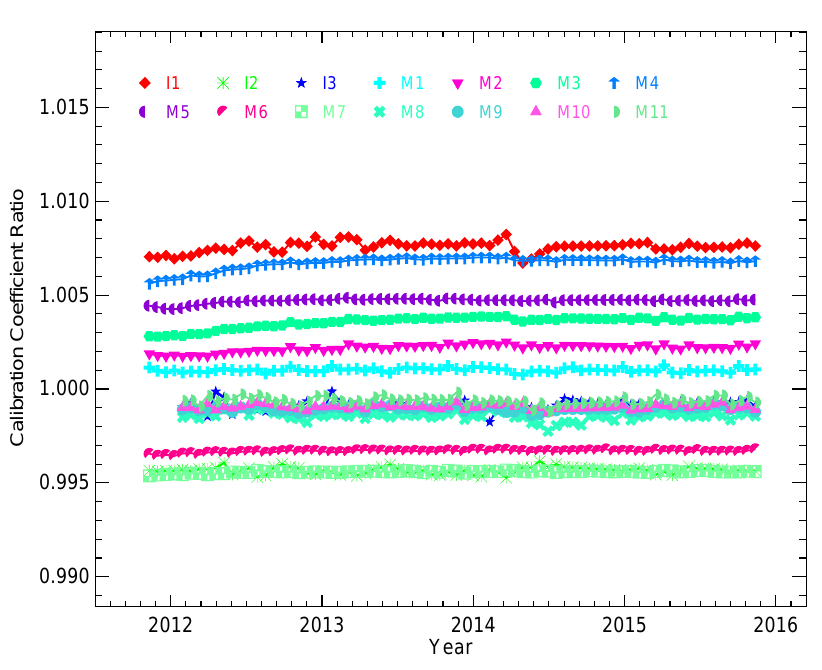
Figure 9. VIIRS RSB HAM 1 HG detector-averaged SD F-factors.